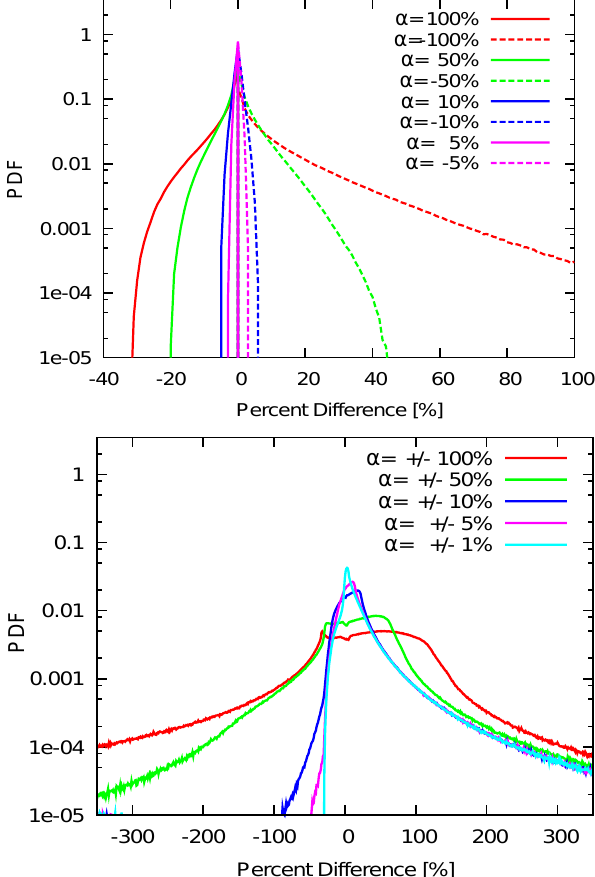
Fig. 6. Probability density function for the error [%] for specific values of α for the first chemical system (top) and the second che- mical system (bottom).